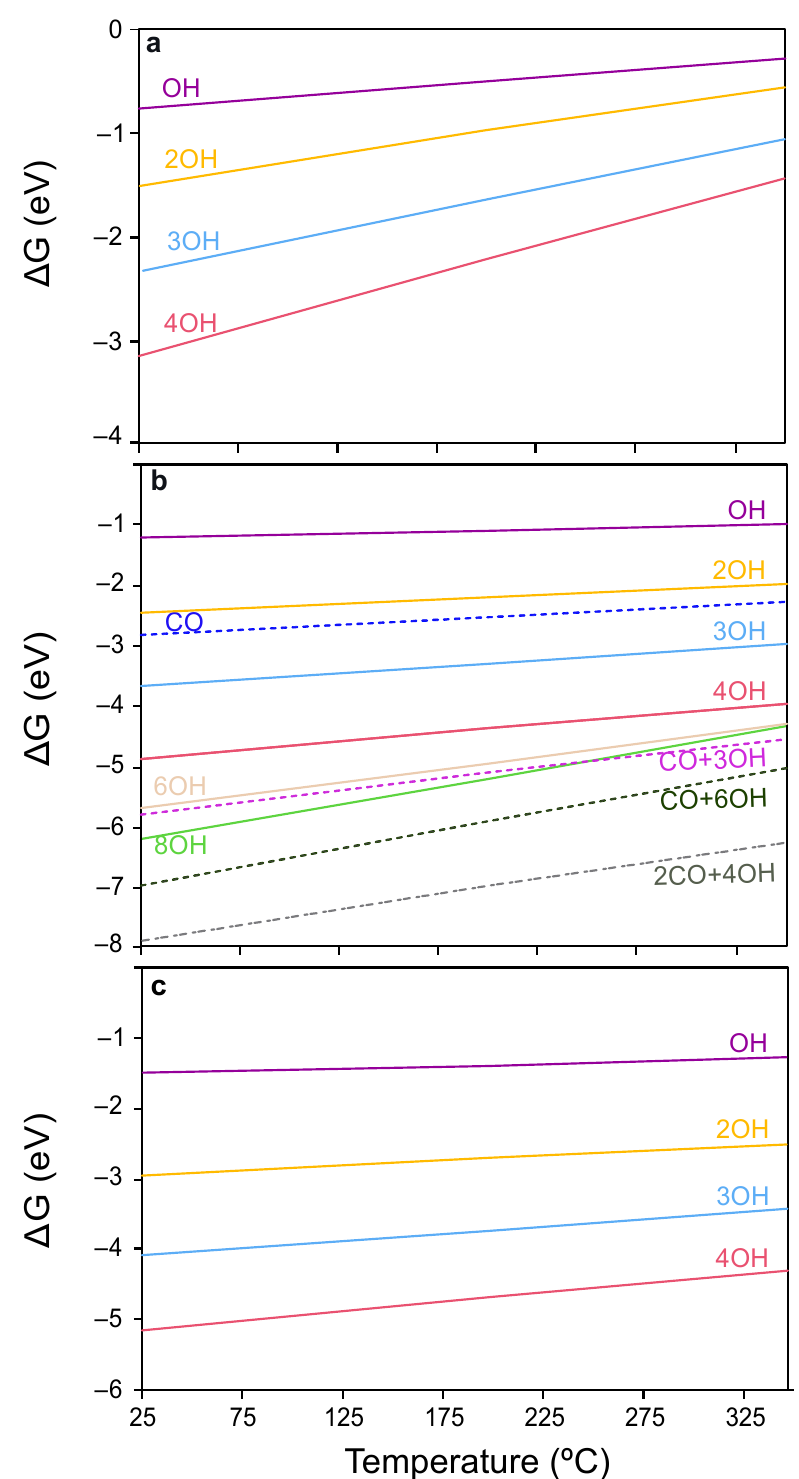
Figure 4. Coverage analysis on the ceria surfaces ( a ) (111), ( b ) (110) and ( c ) (100). Solid lines denote OH coverages, while dotted lines represent mixed coverages of OH and CO groups.